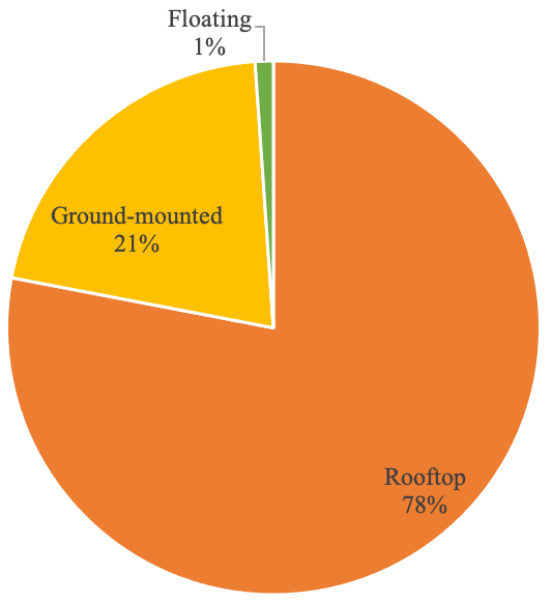
Figure 2. Different proportions of PV power systems in Taiwan (2020). Source: [13,14] self-elaboration.